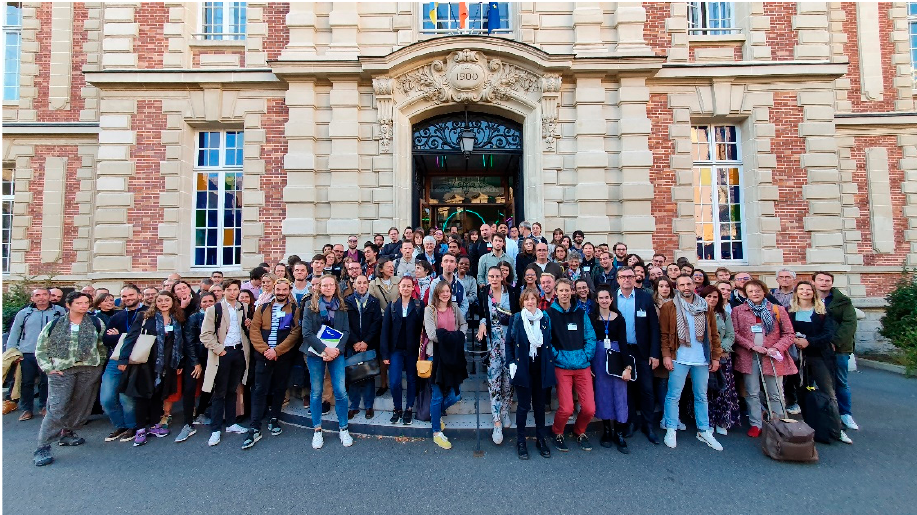
Figure 2. Attendees in front of the historical building at the Institut Pasteur.